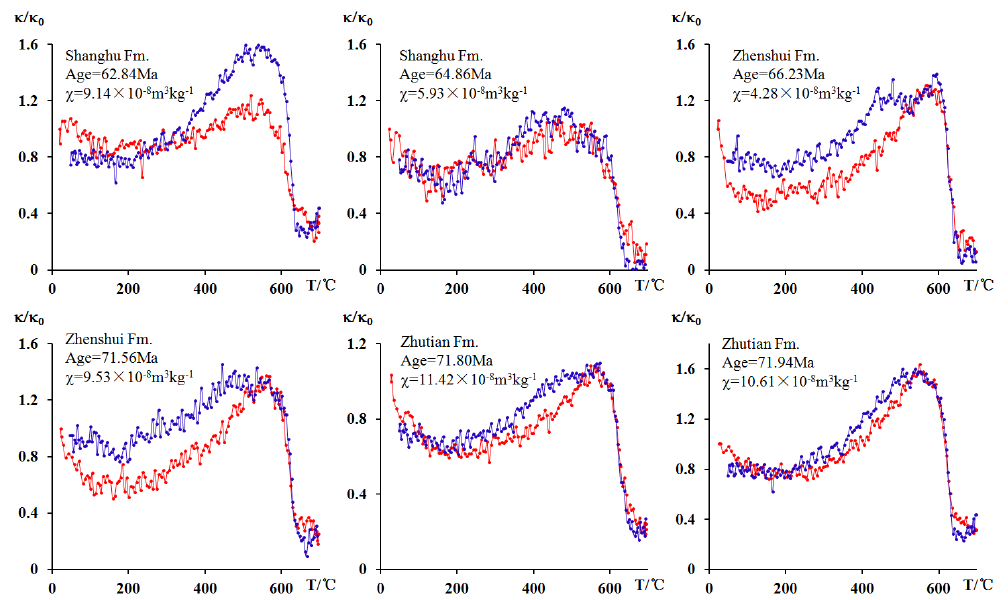
Figure 3. The κ - T curves of pilot samples from the Datang profile (red lines represent heating curves, whereas blue lines indicate cooling